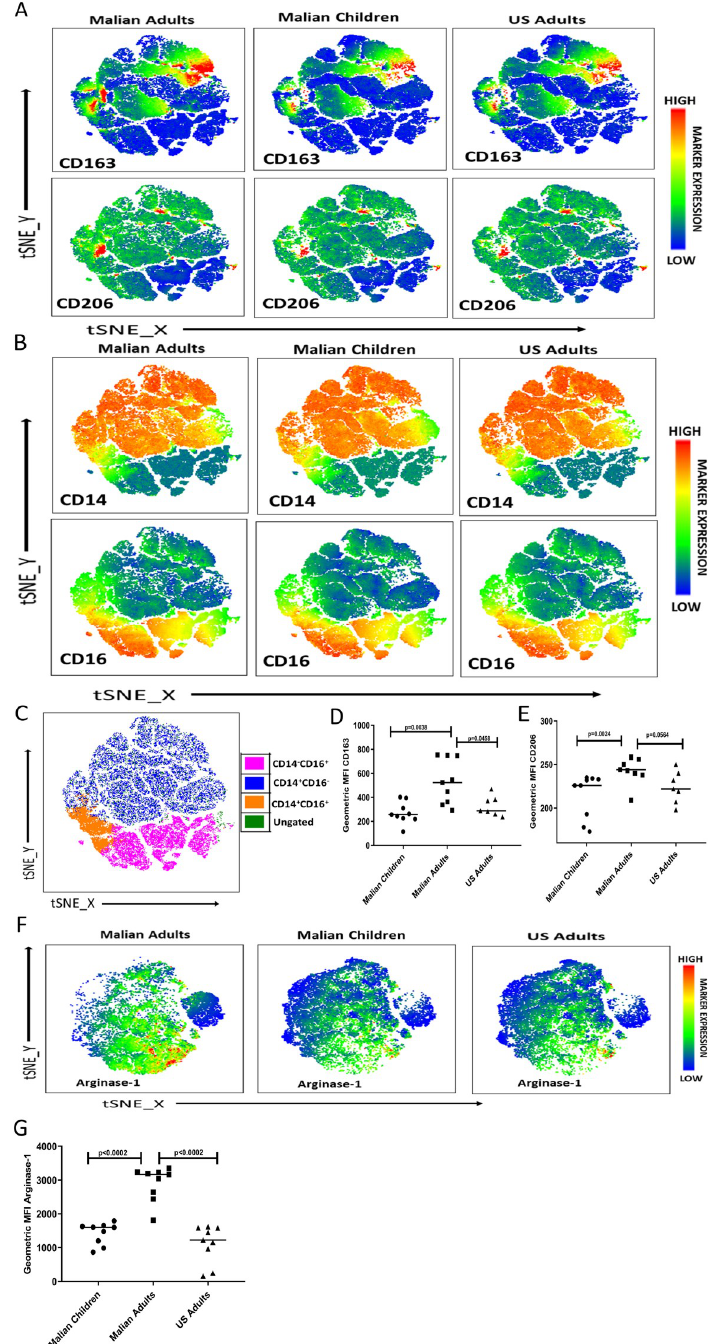
Fig 2. Monocytes of Malian adults upregulate markers of M2 regulatory monocytes/macrophages. ( A-E ) PBMCs from Malian children (aged 4–6 years; n = 9) and adults (n = 9) before the malaria season, as well as healthy malaria- na ï ve U.S. adults (n = 7) were analyzed ex vivo by flow cytometry with gating on live monocytes for surface expression of CD14, CD16, CD163 and CD206. ( A, B ) t-SNE analysis of monocytes for all subjects in each group. Expression levels of each marker are indicated by color scales. ( C ) t-SNE analyzed data (shown in A and B) subjected to gating for monocyte subsets based on CD14 and CD16 expression using concatenated data from all subjects. MFI of ( D ) CD163 and ( E ) CD206 surface expression on manually gated live monocytes. ( F, G ) PBMCs were stimulated with Pf -iRBCs and analyzed for arginase-1 expression in monocytes intracellularly. ( F ) Representative t-SNE plots showing expression of Arginase-1 in the clusters in three different groups of monocytes. Expression of Arginase-1 is indicated